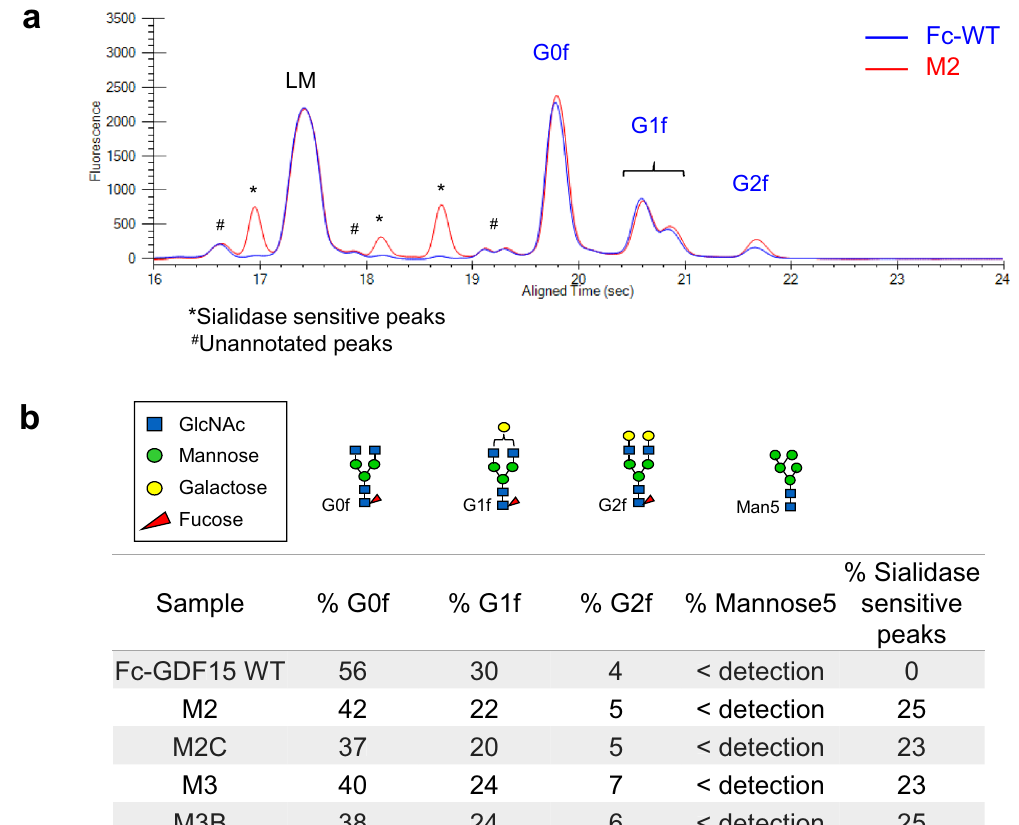
Figure 4. Fc-GDF15 glyco variants contain sialidase sensitive glycans. ( a ) Representative glycan profiling trace using capillary gel electrophoresis, comparing wildtype Fc-GDF15 control (Fc-WT, blue) and Mutant 2 (red). LM, lower marker. Asterisks denote sialidase sensitive peaks. Pound symbols denote unannotated peaks that did not align to glycan standards. ( b ) Summary table of major identified glycan species for Fc-GDF15 WT control and